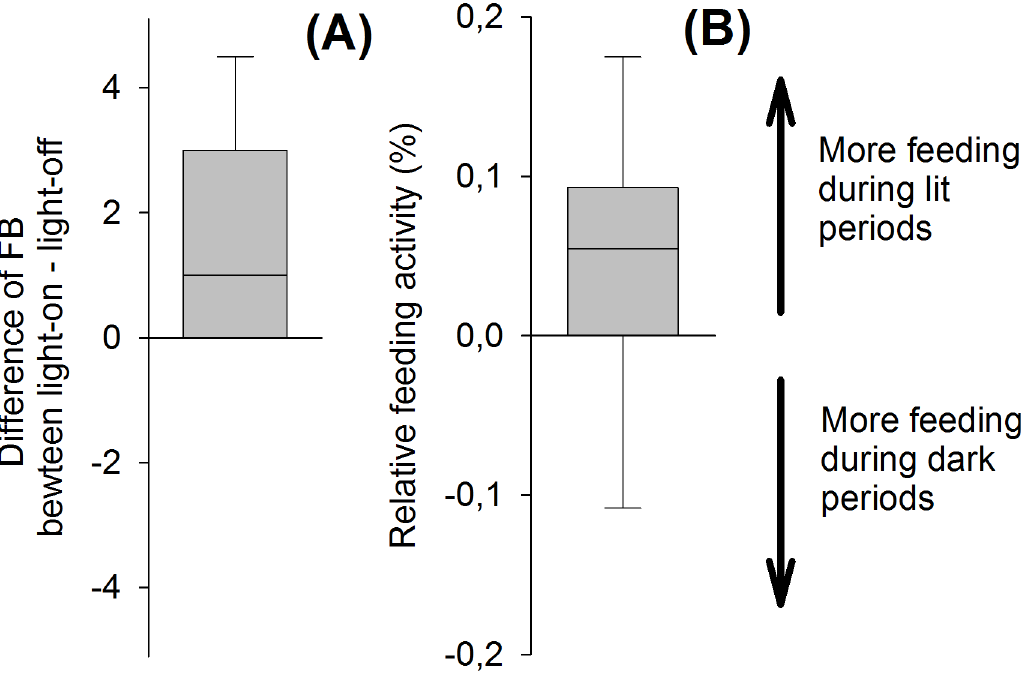
Fig 2. Differencein the cumulative number of feeding buzzes (FB) recorded per night (A) and difference in the relative foraging activity per night (B) at the central pole for P . nathusii . Data are depicted as boxplotswith 25 and 75 percentiles as the border of the boxes and whiskers encompassing 5 and 95